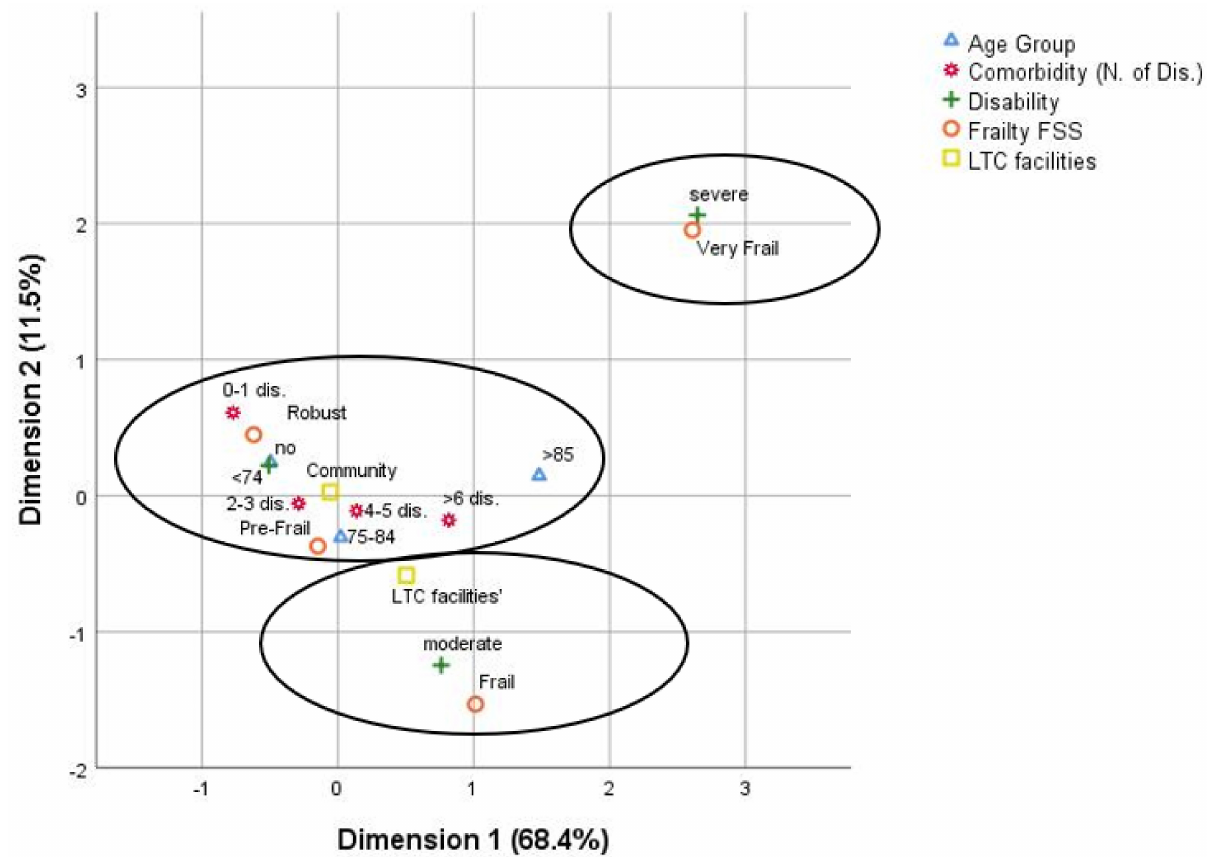
Figure 2. MCA dimension. Categorical variables: Age Group (<74 years, between 75 and 85, and >85); Comorbidity (0–1 dis., 2–3 dis., 4–5 dis, and >6 dis); Disability (no disability, moderate disability, and severe disability); Frailty FSS (Robust, Pre-Frail, Frail, and Very Frail); LTC facilities’ (community- dwelling older people and resident in Nursing Home Facilities or Assisted Living Facilities). Joint category plot of the explored variable categories. Dimension 1 explains 68.4% inertia and dimension2 explains 11.5% inertia. Coordinates are in standard normalization. Two-dimension of MCA solution was considered the most adequate: both presented an eigenvalue, 2.318 and 1.574, and inertia of 0.464 and 0.315 and Cronbach’s alpha, 0.711 and 0.457,